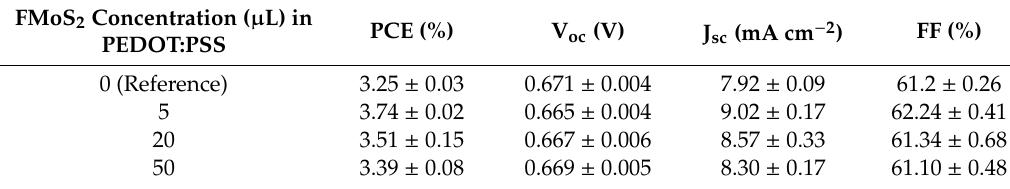
FMoS 2 concentration